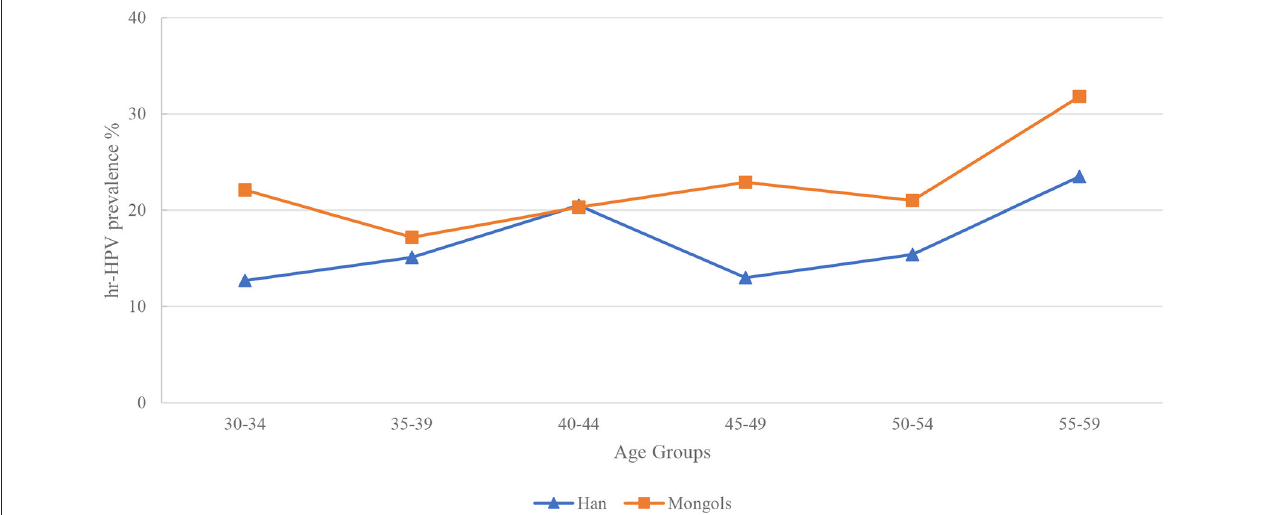
FIGURE 2 | Age-distribution of Hr-HPV prevalence, stratified by ethnicity.